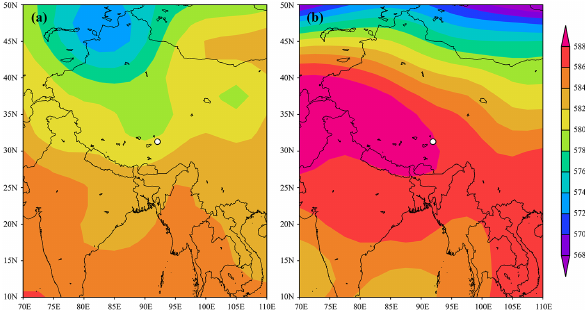
Figure 5. Distributions of the geopotential height (unit: meter) at 500hPa on 6 August (a) and 5 September (b) 2005 over the Ti- betan Plateau and adjacent regions, representing the conditions of low pressure (a) and high pressure (b) over the Nagqu station (white